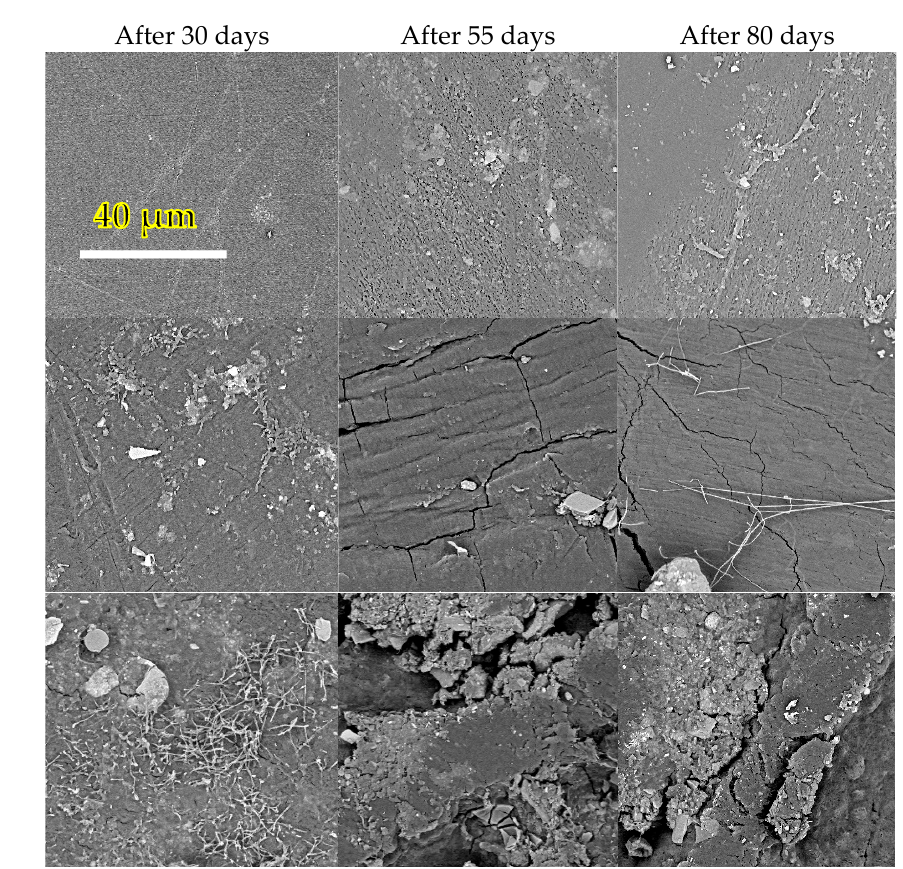
Figure 5. Scanning electron microscopy survey of the sample surface during the biodegradation test at 28 °C (home-composting conditions). Magnification of 5000×. Specifications according to Table 2 (B—500 mL cup, C—200 mL cup, D—sheet for thermoforming, E—blown film and F—blown film with TPS).